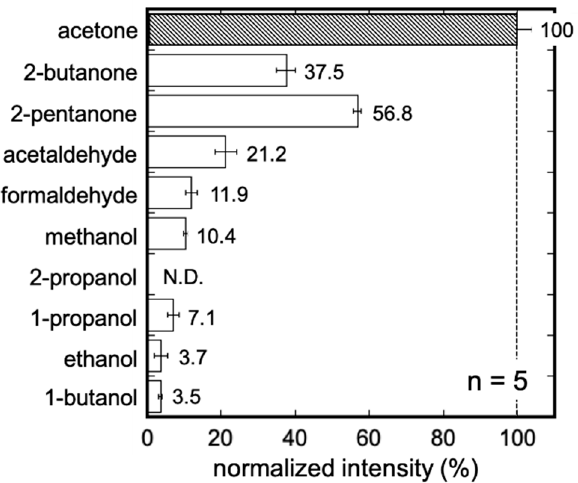
Figure 7. Gas selectivity of the acetone gas imaging system. The normalized intensity (%) detected by the imaging system in response to 2-butanol (1 ppm) and 2-pentanone (1 ppm) was 37.5% and 56.8%, respectively.